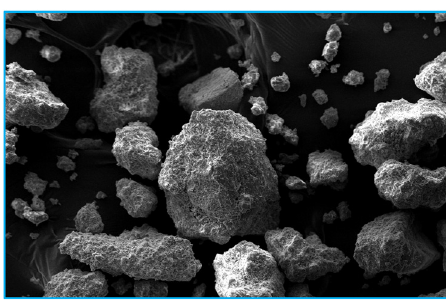
Figure 3: UV - Vis absorption spectrum of ZnNPs and crude methanol extract of C. baccifera .